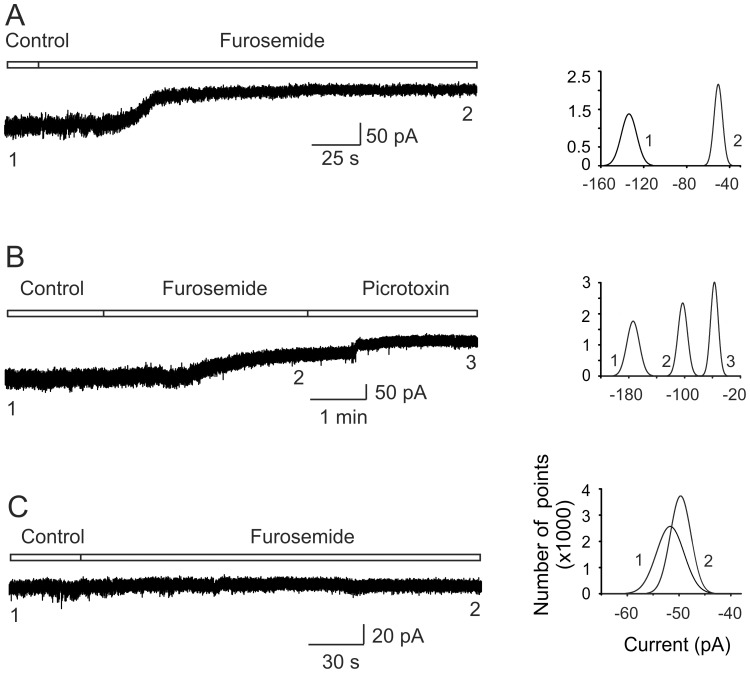
Furosemide sensitive GABAergic tonic current in motoneurons.A) Representative trace of the holding current recorded in one motoneuron held at −70 mV in the presence of furosemide. B) Trace recording of the holding current in another motoneuron in the presence of furosemide after sequential application of picrotoxin. C) Representative trace of the holding current recorded in one motoneuron held at −70 mV in the presence of furosemide. Note that the cell did not respond to drug application. To the right are the histograms built with 500 points taken from the traces at the times indicated by the numbers under the current traces. Recordings in A and B were taken in presence of GABA (40 µM), strychnine (2 µM), CNQX (20 µM) and APV (20 µM). In C, the recordings were made without GABA addition.